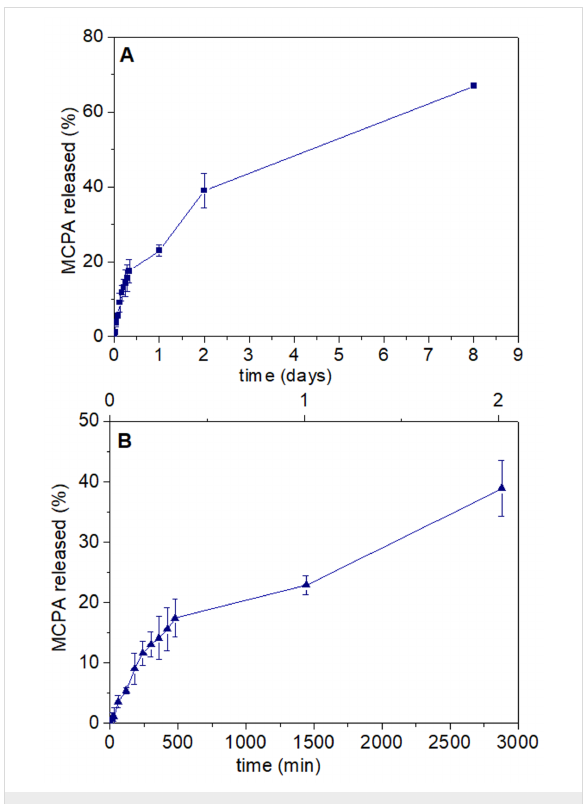
Figure 8: (A) In vitro release of MCPA encapsulated in the A-Z@MCPA-LDH/Sep bionanocomposite system over a period of 8 days in deionized water (pH 5.5), and (B) zoom of the same graph in the first 48 h of